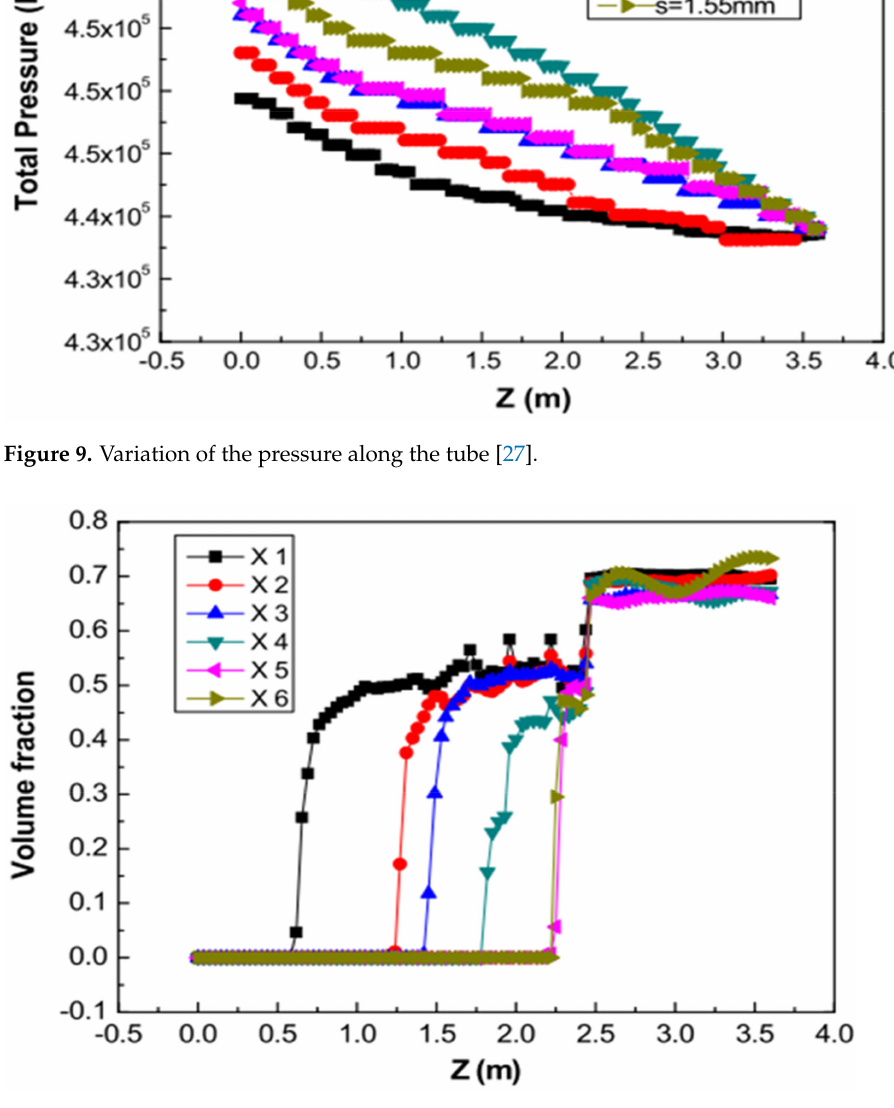
Figure 10. Volume fraction along the tube at various velocities